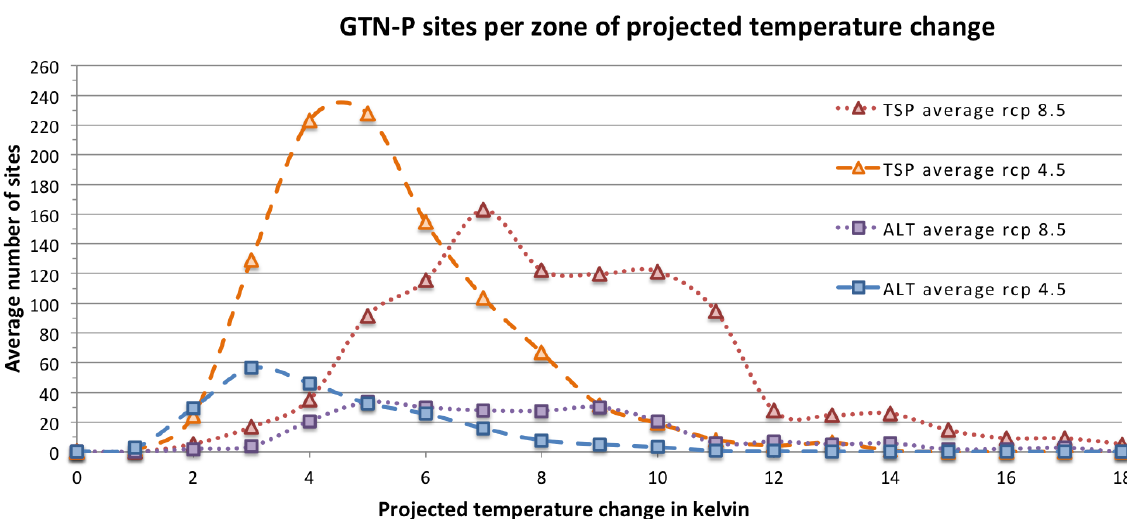
Figure 10. Average number of GTN-P sites within zones of projected temperature change calculated from 15 climate models: ACCESS1-0, bcc-csm1-1, CanESM2, CCSM4, CNRM-CM5, CSIRO-MK3-6-0, GISS-E2-H, GISS-E2-H, GISS-E2-R, HadGEM2-ES, inmcm4, IPSL- CM5A-LR, MPI-ESM-LR, MRI-CGCM3 and NorESM1-M. rcp: representative concentration pathway. KML files for visualization of the TSP and ALT locations and the listed climate models in Google Earth are available at